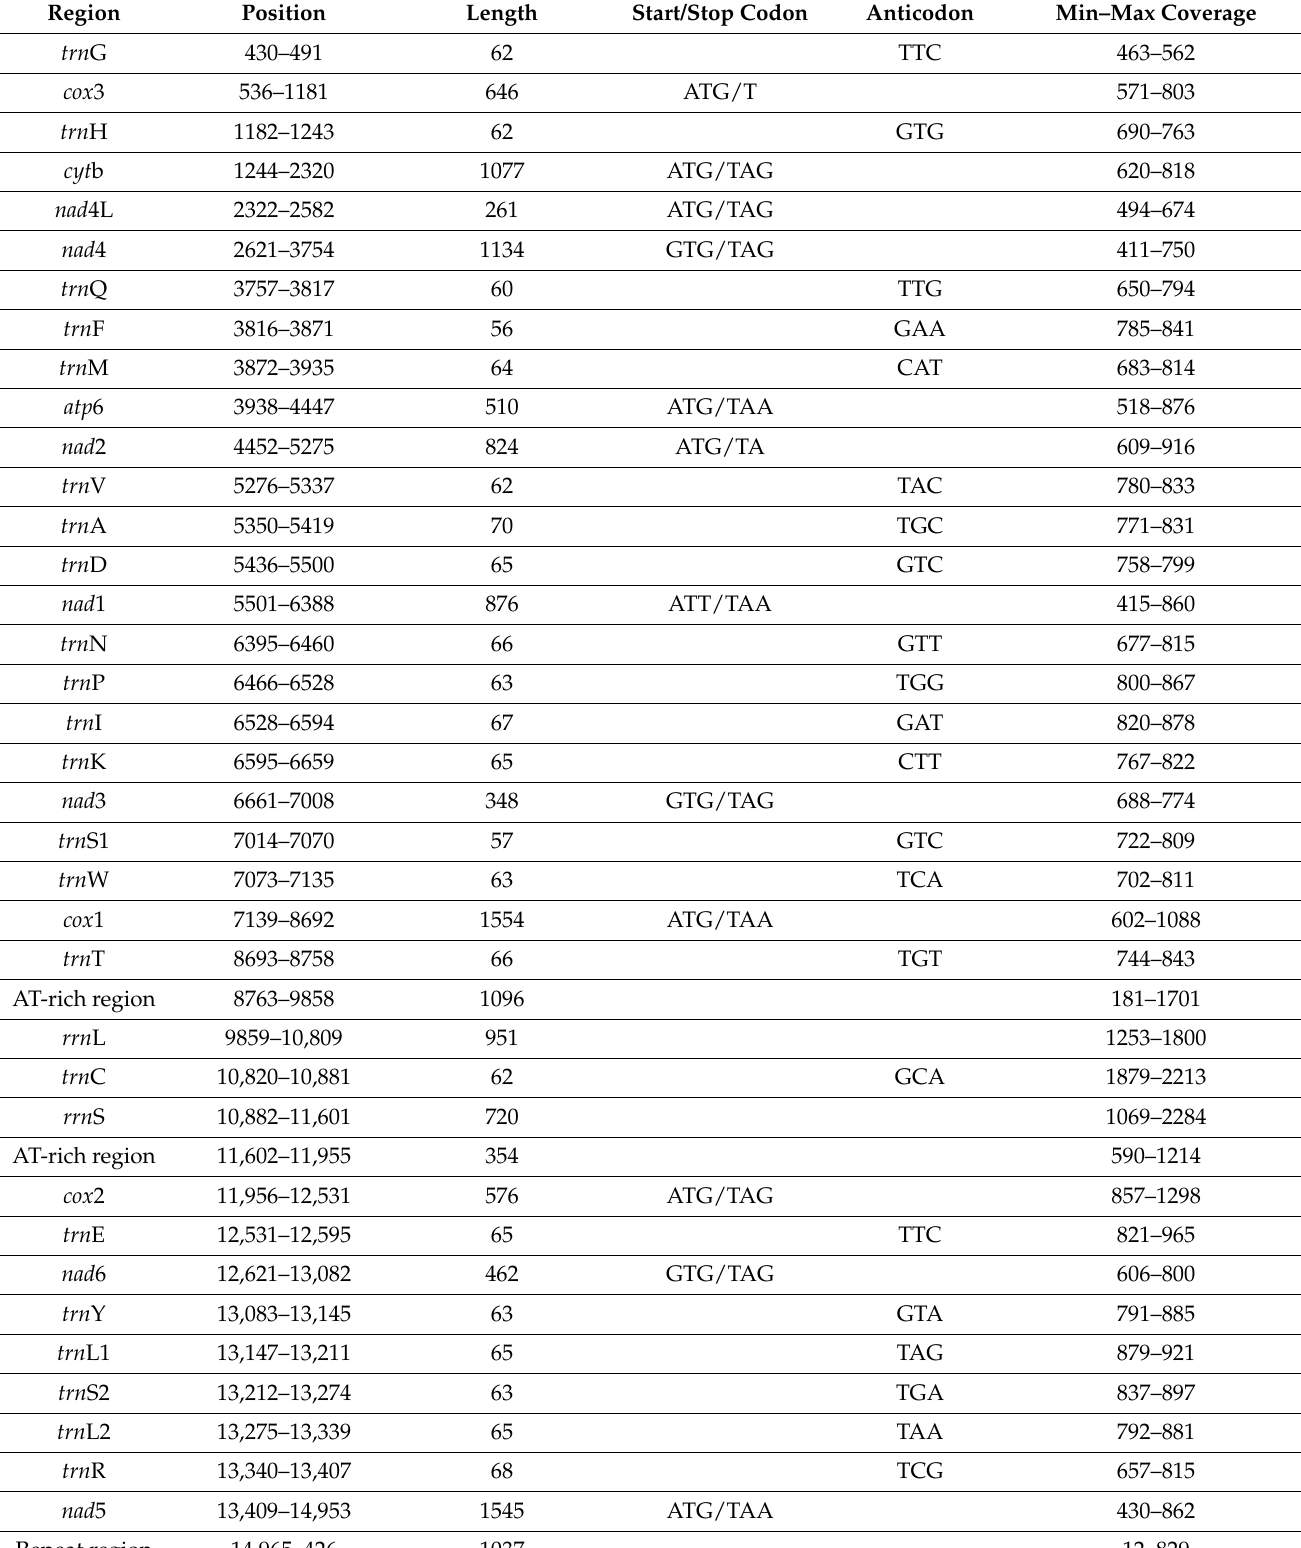
Table 2. Overview of the length (in bp) of mitochondrial regions, the start and stop codons (protein-coding genes), anticodons (tRNA genes), and minimum–maximum coverage in the assembled mitogenome of Cichlidogyrus casuarinus ex Hemibates stenosoma based on a pooled sample of 80